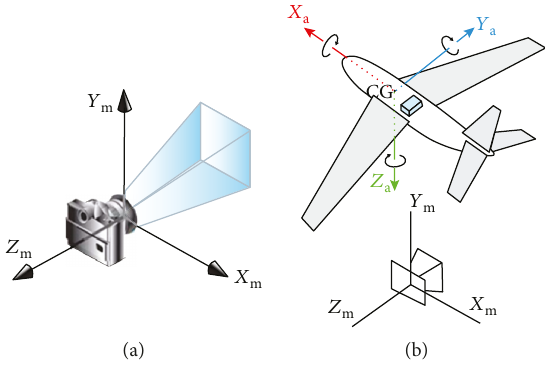
Figure 13: (a) Photogrammetric system and (b) aeronautical